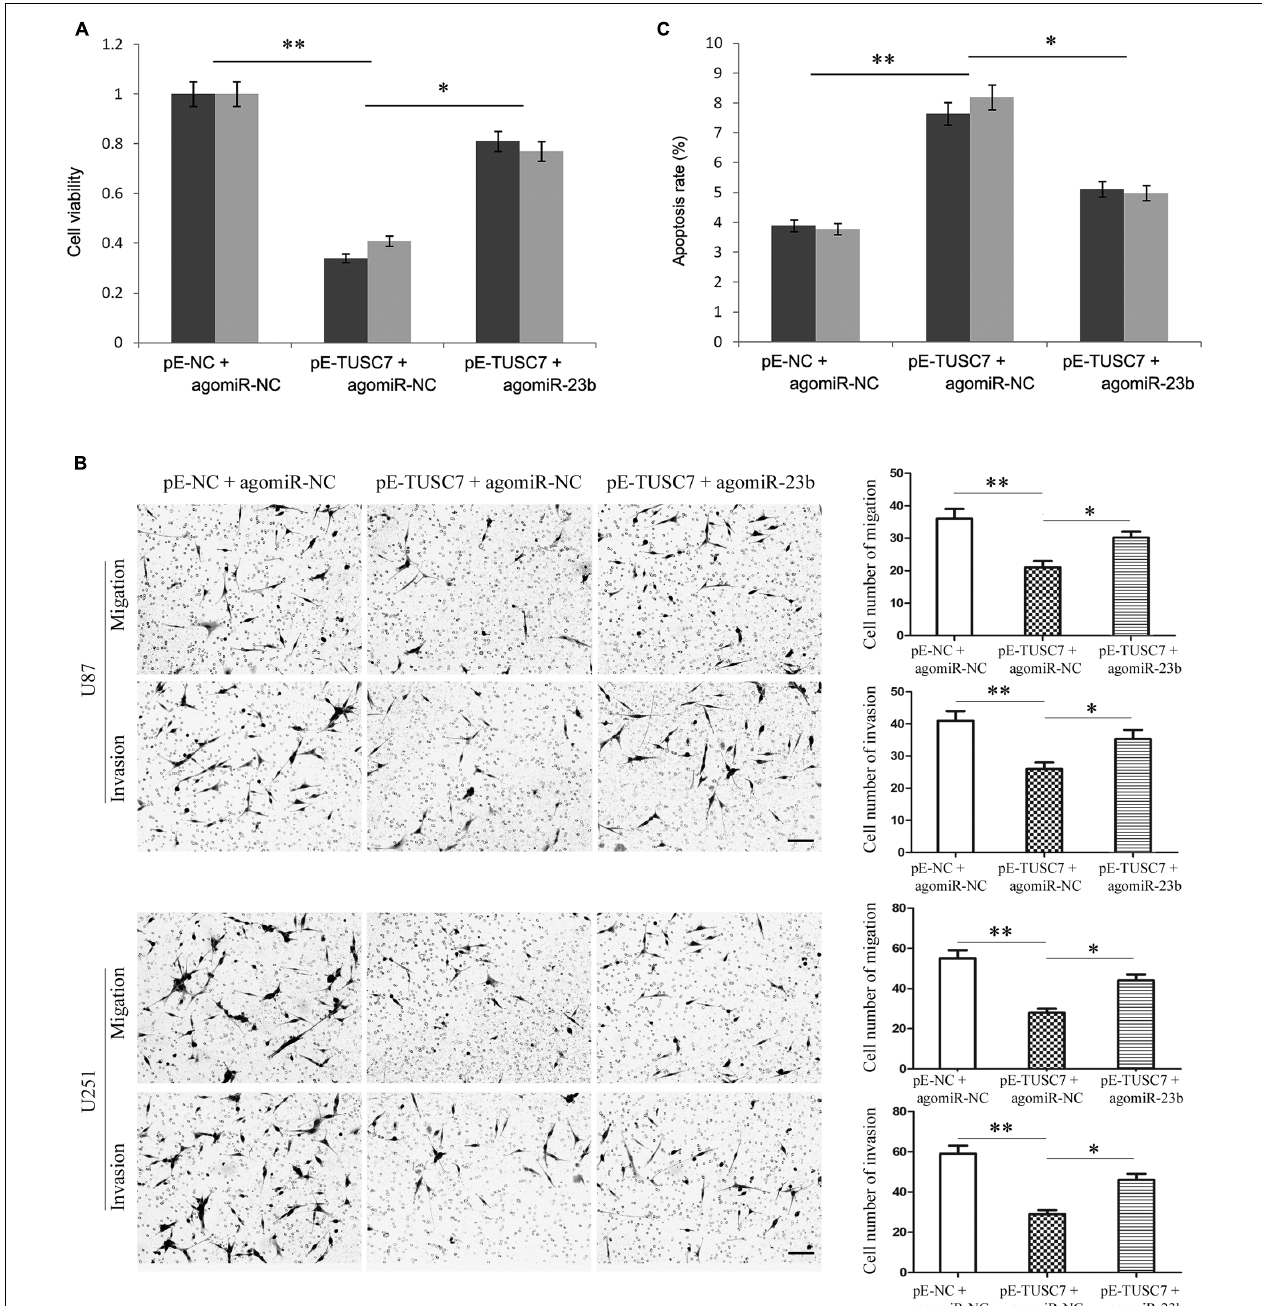
FIGURE 6 | Over-expression of miR-23b partly reversed TUSC7-induced inhibition of proliferation (A), migration and invasion (B), and partly reversed TUSC7-induced apoptosis (C) in U251 and U87 cells. Scale bars represent 100 µ m. ∗ P < 0.05, ∗∗ P <